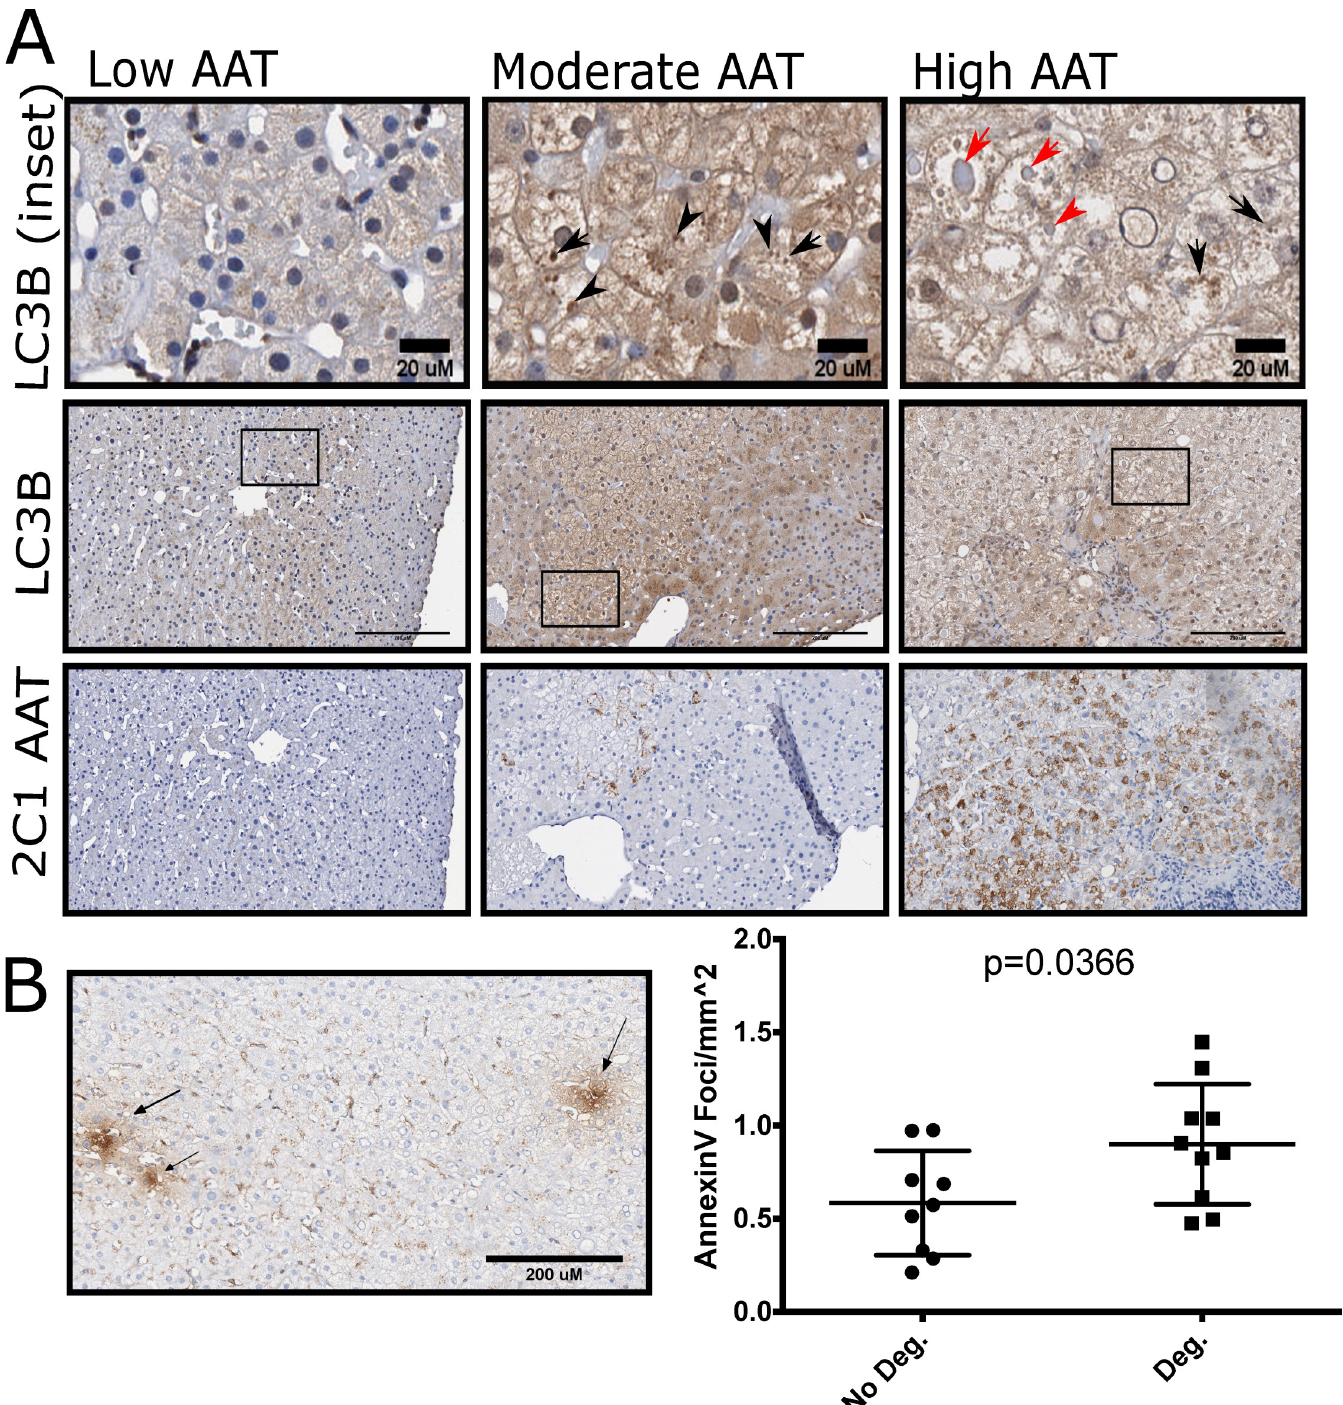
Fig 5. Autophagy connects toxic gain of function to cellular degeneration. (A) Representative images from n = 20 PiZZ subjects comparing polymer accumulation, LC3B staining and hepatocyte degeneration. The top row is an inset of LC3B staining from the middle row (marked with a black box). AAT polymer staining in the same region is presented in the bottom row. individuals with moderate and high accumulation of AAT. Black Arrows represent puncta of LC3B in degenerate hepatocytes. Red Arrows represent staining of LC3B around AAT inclusions. (B) Representation and quantification of Annexin V Foci (Black Arrows) were more prominent in individuals with degeneration, Bars represent mean and standard deviation p-value is calculated from student’s t-test.